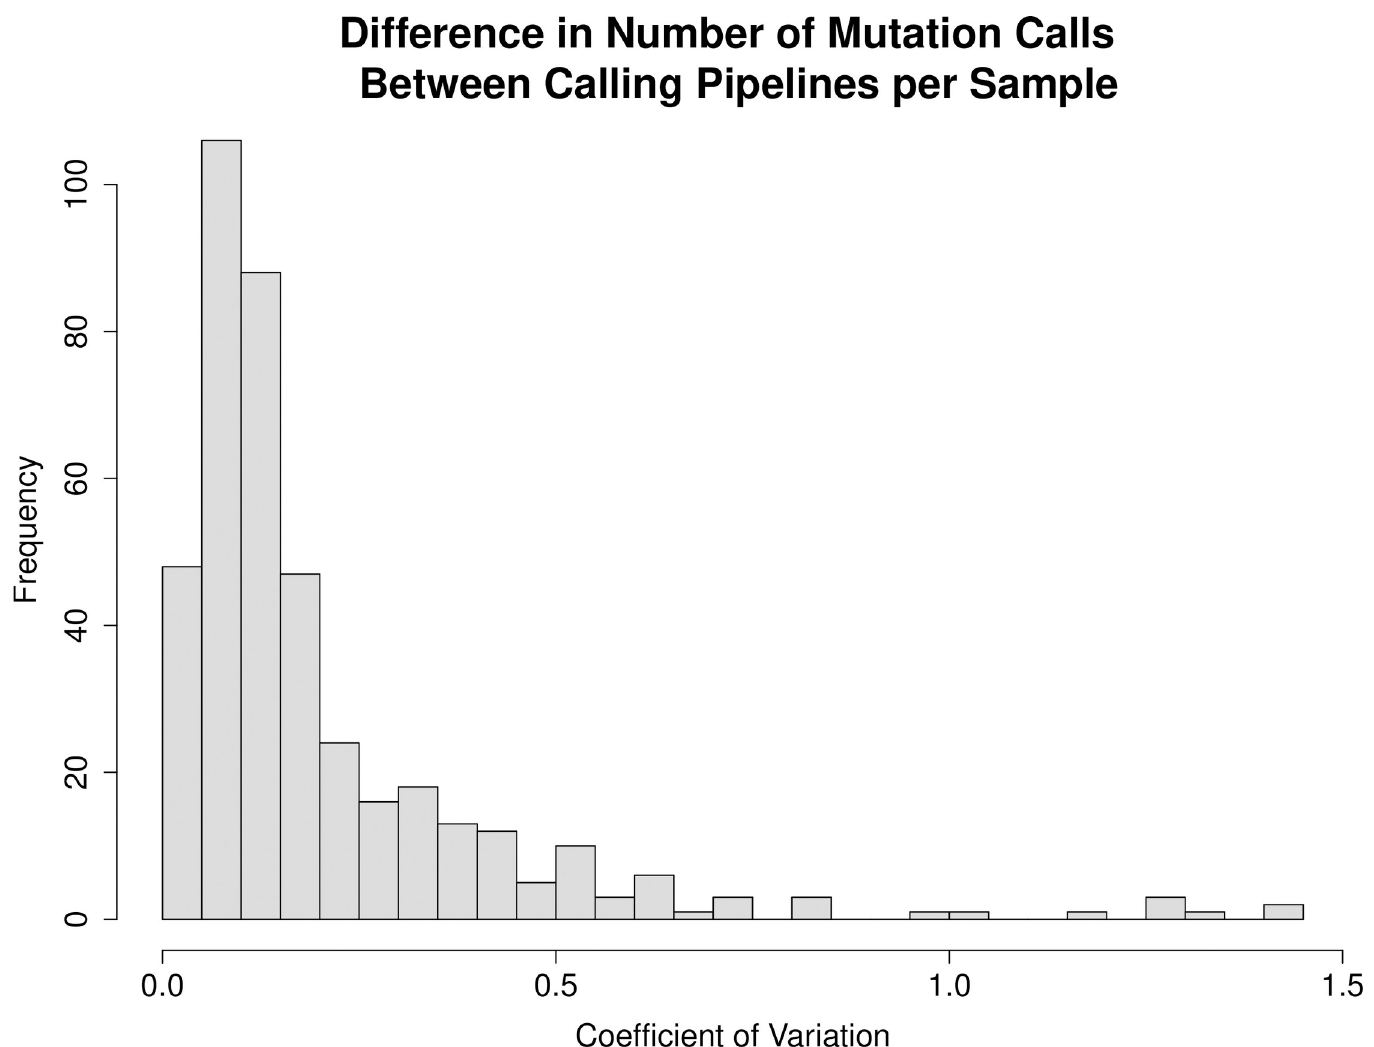
Fig 2. Coefficients of variation (CV) for the cases of MIBC represented in the different mutation annotation file (MAF).